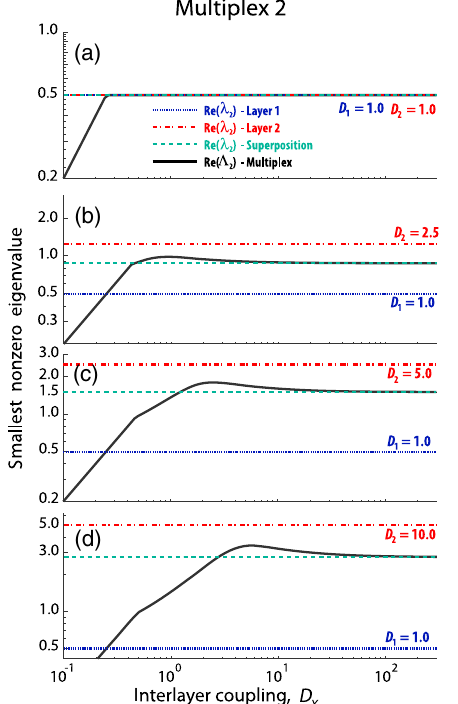
FIG. 5. Characteristic rate of convergence to stationary state solution of a continuous-time Markov chain on multiplex 1 for different pairs ð D 1 ; D 2 Þ . The value of the smallest (in terms of its real part) nonzero eigenvalue ( Λ 2 ) of the supra-Laplacian is displayed as a function of interlayer coupling D X .